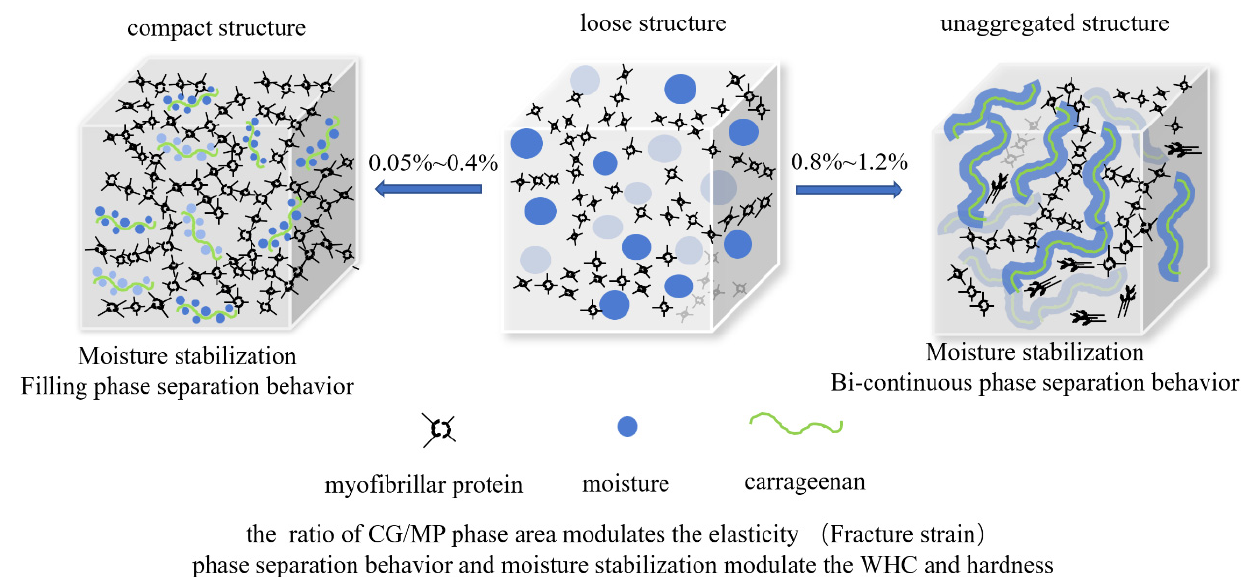
Figure 5. The physicochemical characteristics of MP gels influenced by CG through phase behavior and water immobilization.